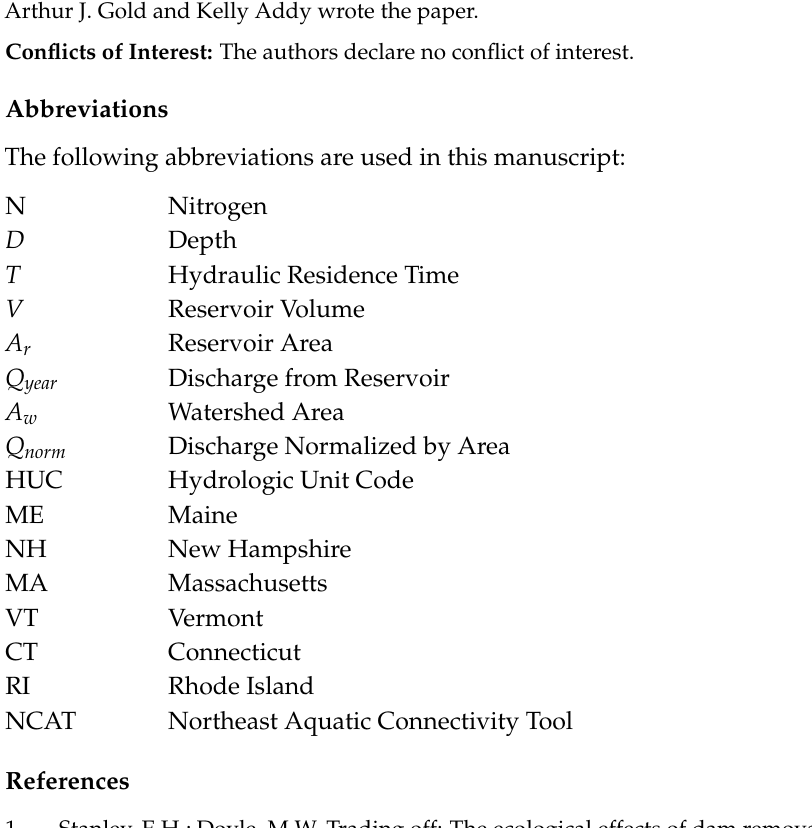
Table S1: Nitrogen Removal Dams of Rhode Island: Attributes and